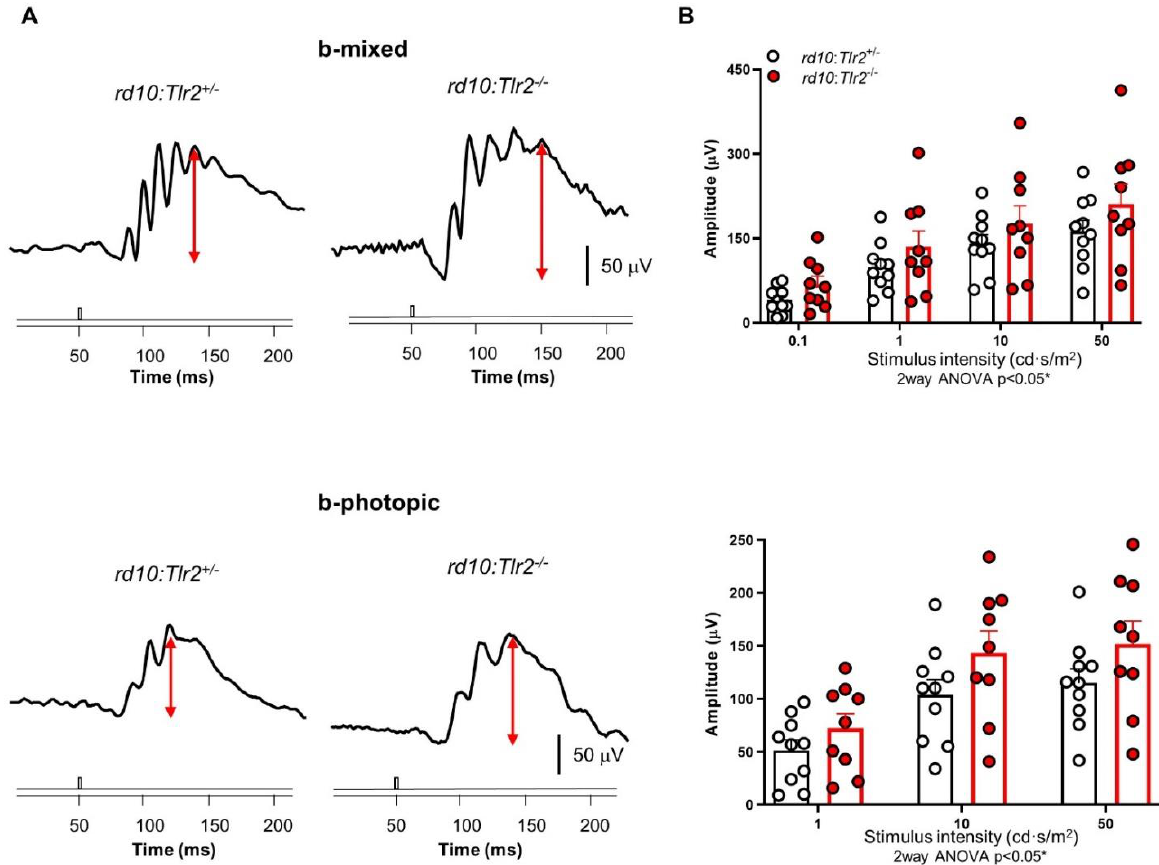
Figure 2. ERG response of rd10:Tlr2 +/ − and rd10:Tlr2 − / − mice. ( A ) Representative ERG responses of rd10:Tlr2 +/ − and rd10:Tlr2 − / − mice (P35) to a stimulus of 50 cd · s/m 2 . The value of the scale bar is indicated in the figure. ( B ) Graphs show mean ERG wave amplitudes, plotted as a function of light stimulus. Amplitudes of rod and cone mixed responses (b-mixed waves) to the indicated light intensities were recorded under scotopic conditions after overnight adaptation to darkness. Amplitudes of cone responses (b-photopic waves) to the indicated light intensities were recorded under photopic conditions after 5 min of light adaptation (30 cd · s/m 2 ). Dots represent individual mice and bars represent the mean (+SEM) for each group. n = 9–10 animals per group. * p < 0.05 (2way ANOVA).